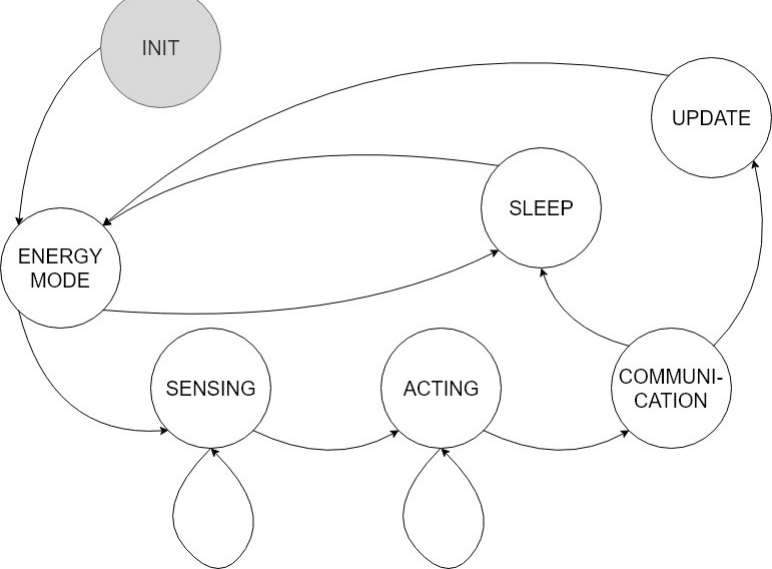
Figure 3. A state machine defined using the logic modules